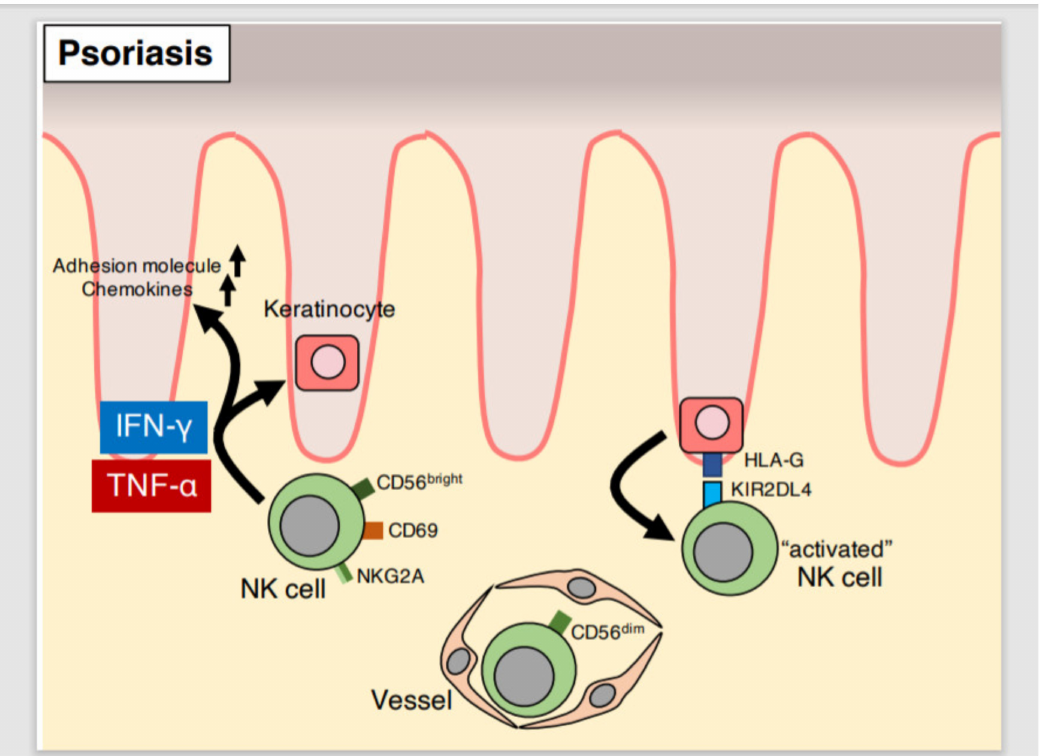
Figure 4. Role of NK cells in psoriatic lesions. In healthy skin, CD56 bright NK cells are localized to the dermis, and CD56 dim NK cells are present predominately in the peripheral blood. In psoriatic skin, CD56 bright NK cells are increased and express the activation marker CD69. Keratinocyte HLA-G expression is increased in psoriatic lesions, which may induce NK cell IFN- γ and TNF- α